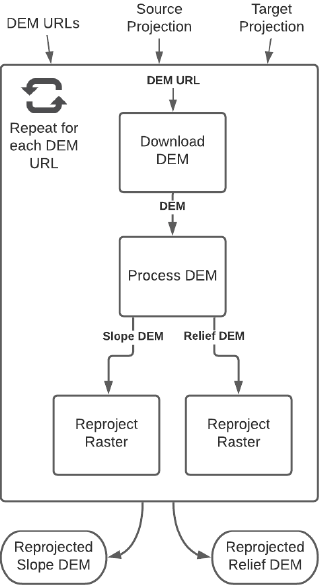
Figure 13. A sample workflow definition in the proposed workflow definition model.